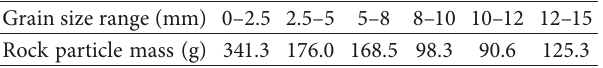
Figure 1: Testsystem.I-porewaterpressurecontrolapparatus,II-dataacquisitionapparatus,III-seepageapparatus,IVpressmachine(MTS816.03), S1–S5 switches, A-hydraulic pump station, B-pressure relief valve, C-reversing valve, D-one-way valve, E-double-acting hydraulic cylinder, F-water pump, G-fluid flow meter, H-pressure transducer, I-paperless recorder, J-computer; K-water outlet. (1) Water inlet piston, (2) O-shape rubber seal ring, (3) upper porous plate, (4) sealing material, (5) rock specimen, (6) lower porous plate, (7) cylinder tube, and (8) based Table 1: The details of mass amount of filling material particles in each grain size range to each specimen (Talbot exponent n � 0 . 6).